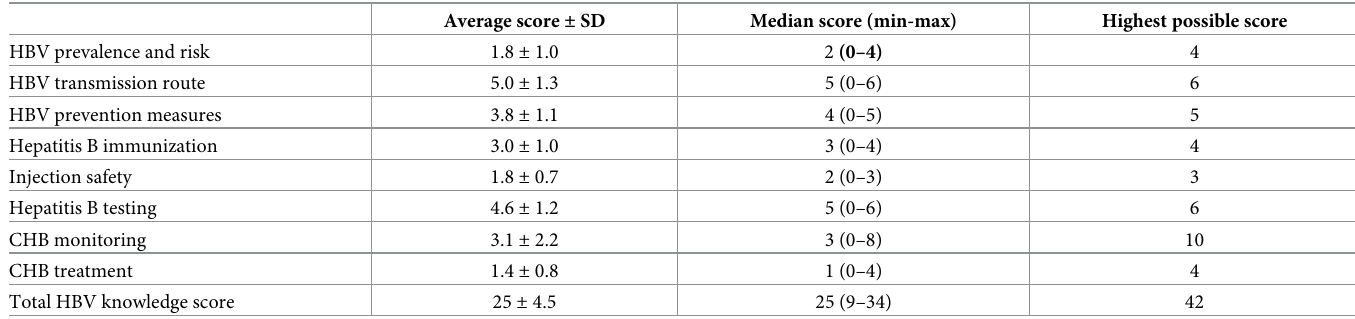
Table 4. Average and maximum score of different domains of HBV knowledge (N =